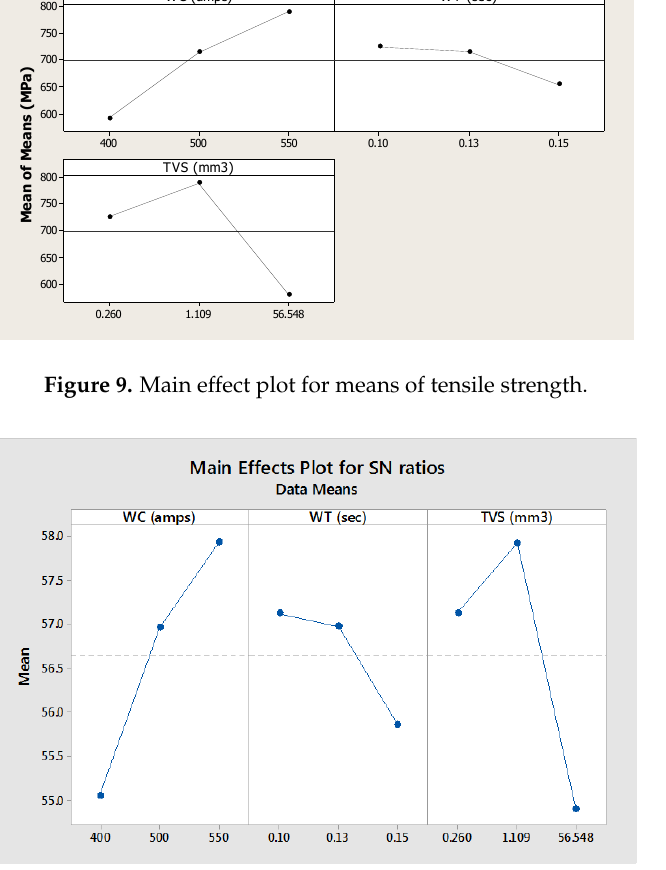
Figure 10. Main effect plot for signal-to-noise (S/N) ratios of tensile strength. The optimum level setting of welding factors is the level showing the maximum value of S/N ratio. Figure 11 provides an interaction plot for the ultimate tensile strength.